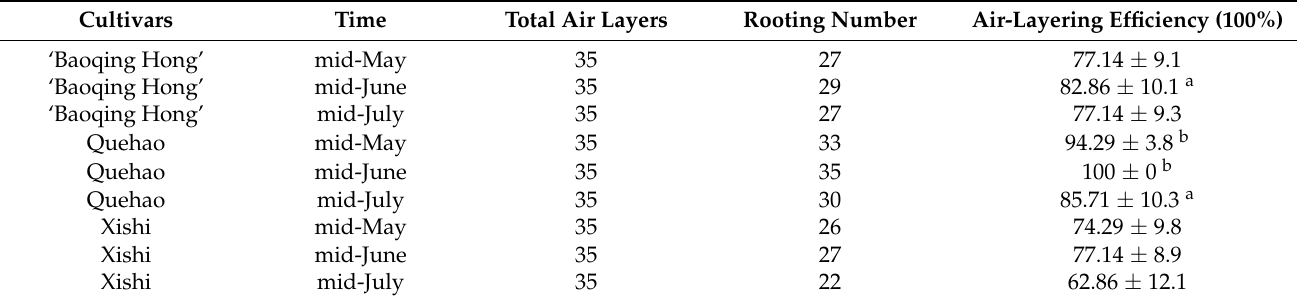
Table 1. Air-layering efficiency for the three tested tree